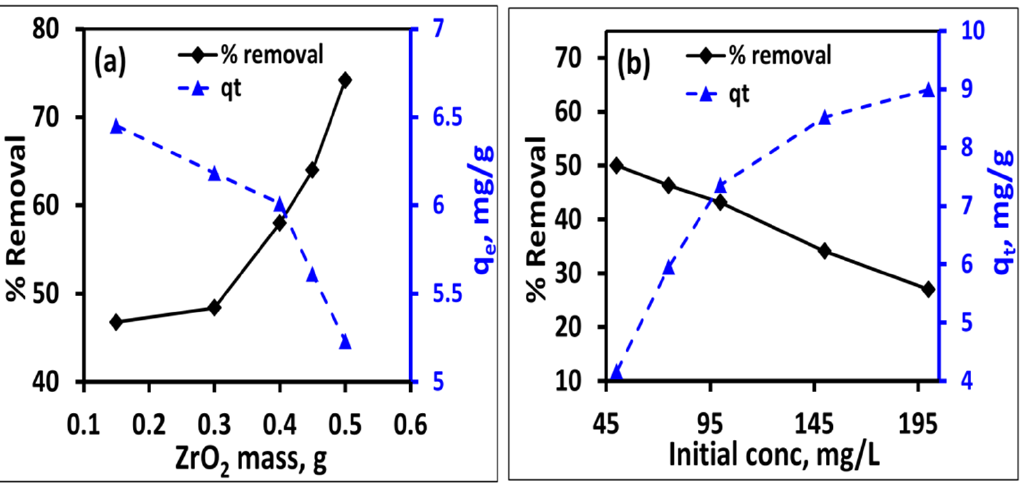
Figure 7. Effect of ( a ) ZrO 2 NPs mass ( λ = 667, time: 30 min, volume: 50 mL, Co 2+ conc: 100 ppm, pH: 6.5) and ( b ) initial Co 2+ concentration on its removal% ( λ = 667, time: 30 min, volume: 50 mL, ZrO 2 mass: 0.3 g, pH: 6.5).